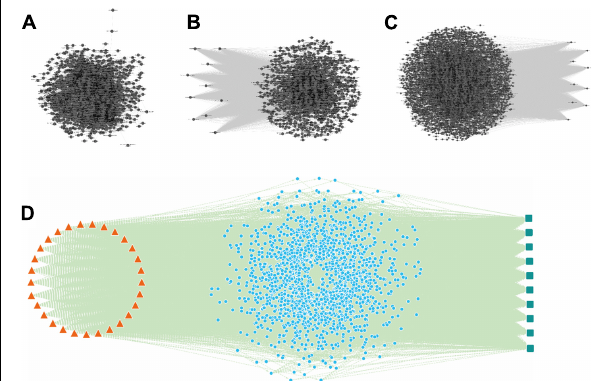
FIGURE 5 | The “component-gene ontology-effect” three-mode network of Schisandra . Firstly, the AMI target related gene ontology interaction (GOI) network (B) was constructed by mining and enrichment of AMI related target genes. Secondly, the target proteins screened through identified Schisandra components were enriched into GO terms. The interactions between GO and the component were constructed and visualized through the “component-gene ontology” two-mode network (A) . Then, the “gene ontology-effect” two-mode network (C) for the treatment of AM pharmacological effects was constructed from the target data collected from reference mining. Finally, the three sub-networks were integrated, and the same GO nodes were combined to obtain a “component-gene ontology-effect” three-mode network (D) . The triangle in orange represents the components identified from Schisandra , the blue circle represents the common GO which are both relevant to the components and effects (green square).